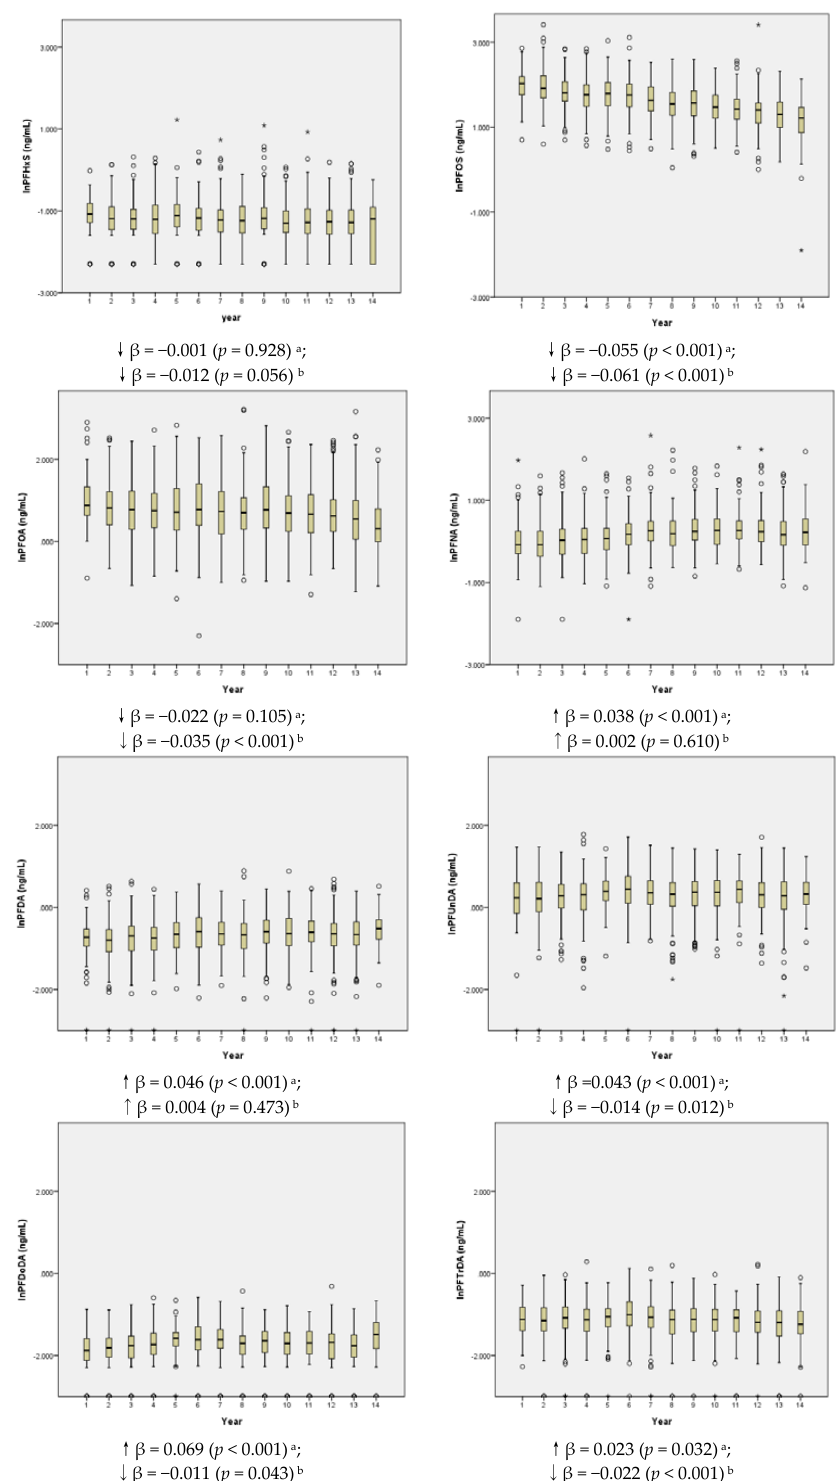
Figure 1. PFAS temporal trend of Hokkaido Study in 2123 pregnant women c . ( a represented the period between August 2003 and January 2006; b represented the period February 2006 and July 2012; c linear regression adjusted for age and parity; Bold represented p value < 0.05; Detail blood collection period and sample size at each period please see the Supplementary Table S2.).